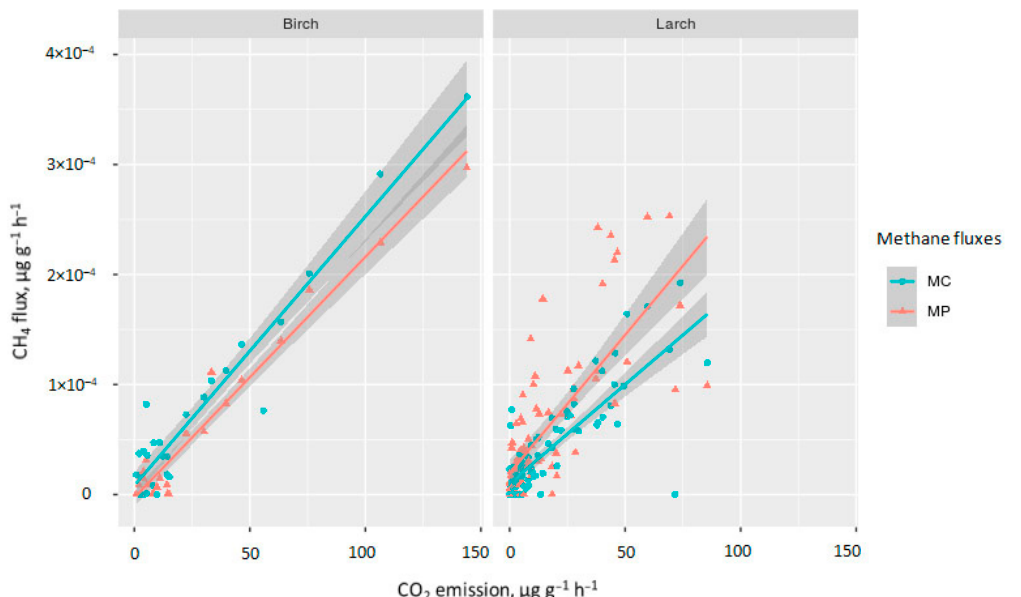
Figure 6. The relationship between CO 2 emission and CH 4 fluxes during decomposition of birch and larch CWD samples: MP—methane production, MC—methane consumption. Shadowed area indicates the 95% confidence interval of the trend line.